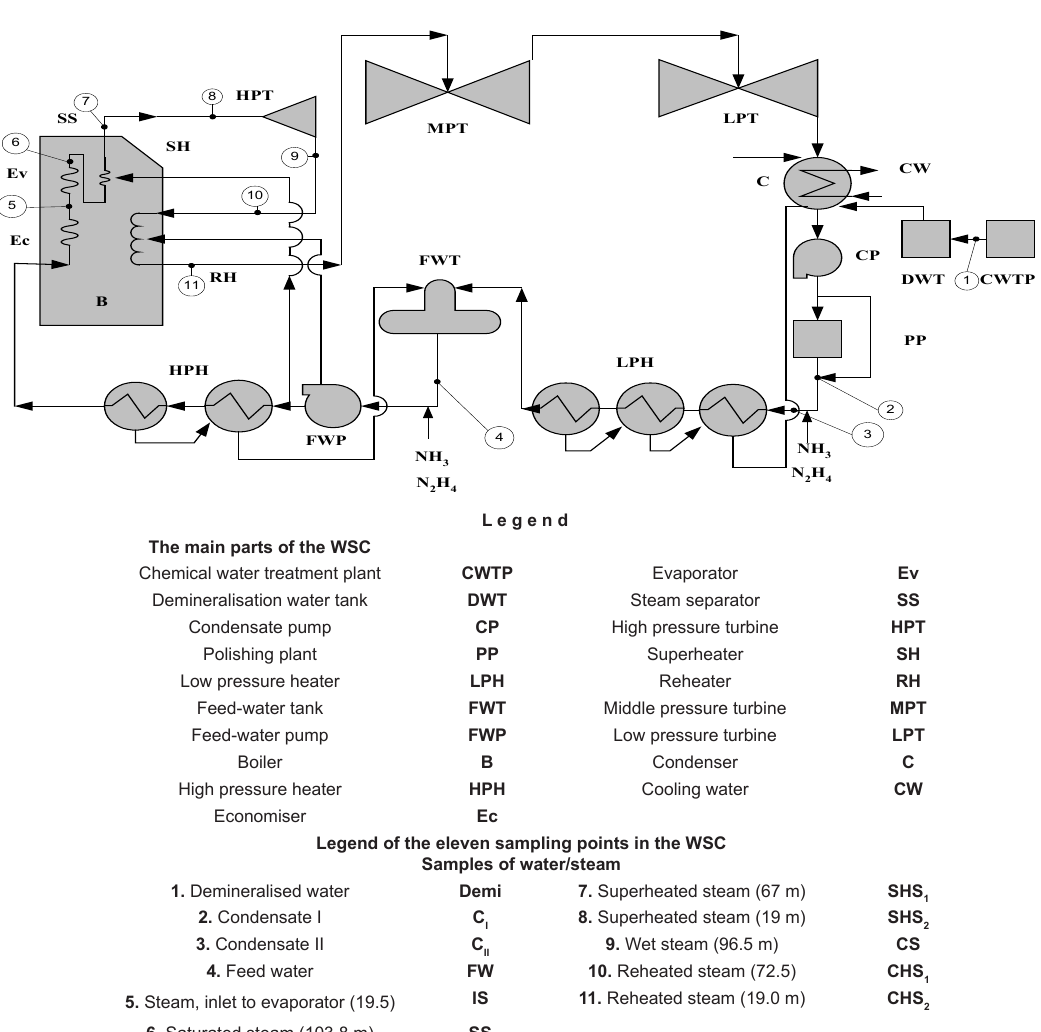
Figure 2. A scheme of the WSC of the TPP Nikola